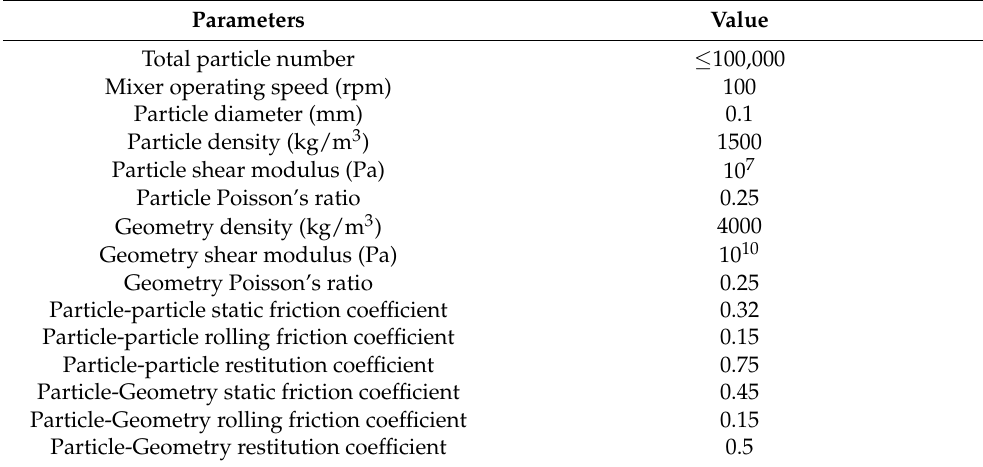
Table 1. Parameters used in the DEM simulation.